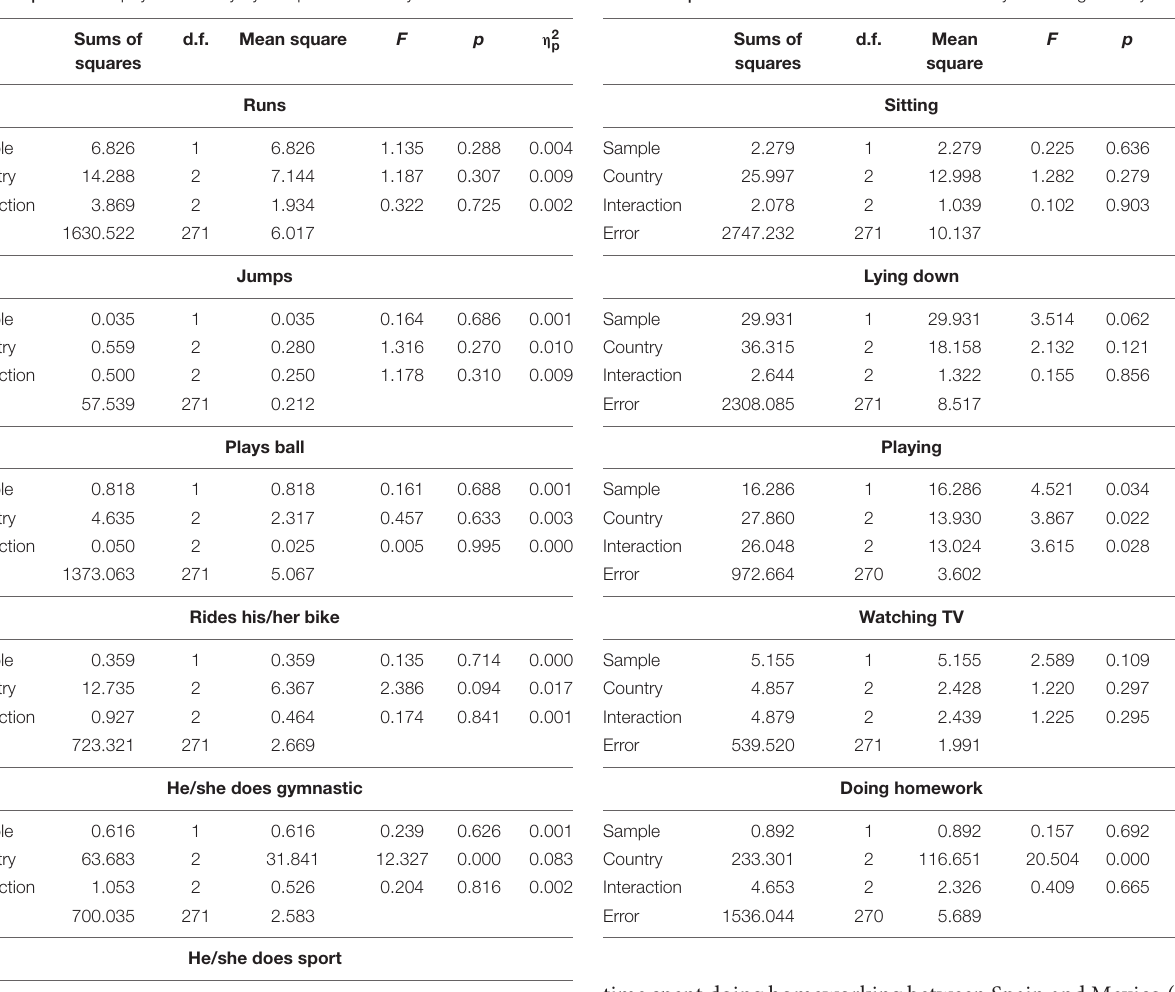
TABLE 10 | ANOVA of the differences in activities they do during the